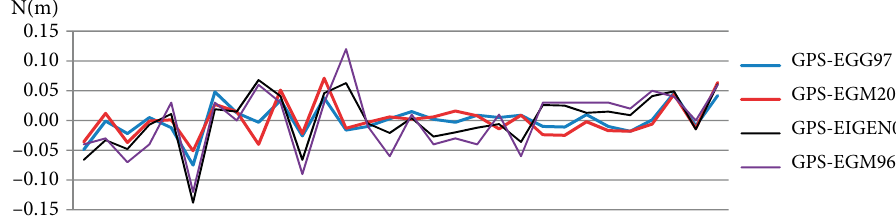
Fig. 4. Geoid height residuals to GPS/Leveling points